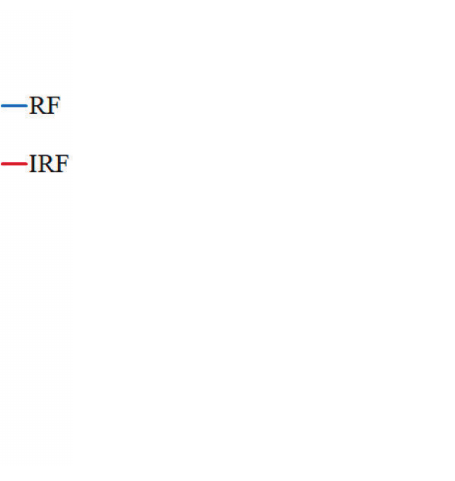
Figure 10. Spider graph representing the sensitivity of the well performance to each variable